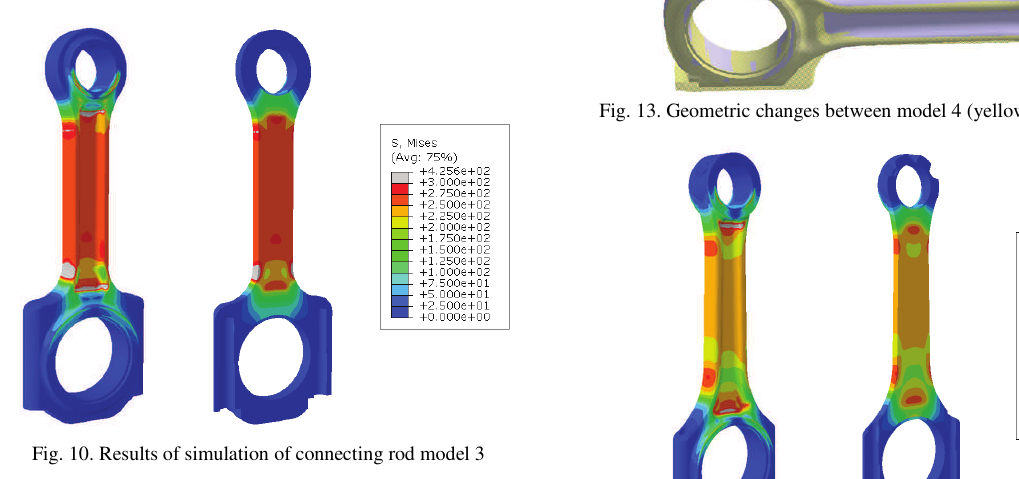
Fig. 9. Geometric changes between model 2 (gray) and model 3 (yellow)